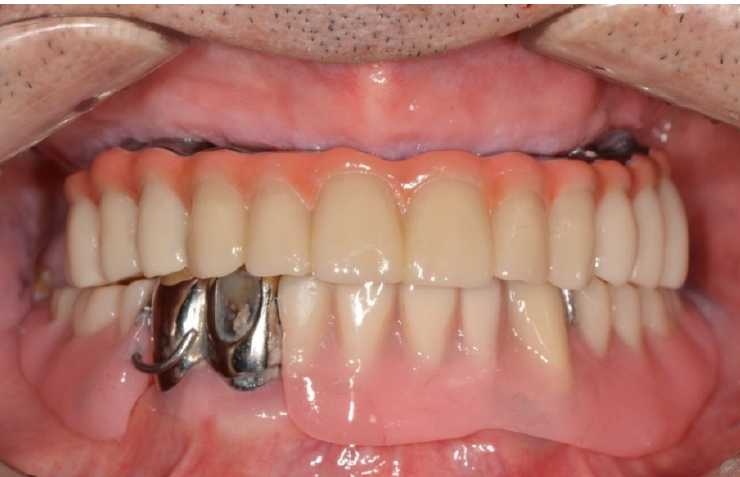
Figure 9. After extraction of tooth #33, the mandibular prosthesis immediately completed by CAD/CAM using the patient’s existing 3D